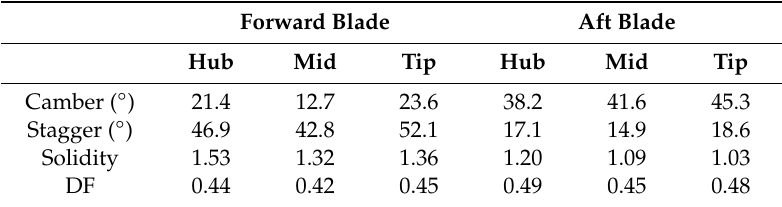
Table 2. Tandem stator design parameters.